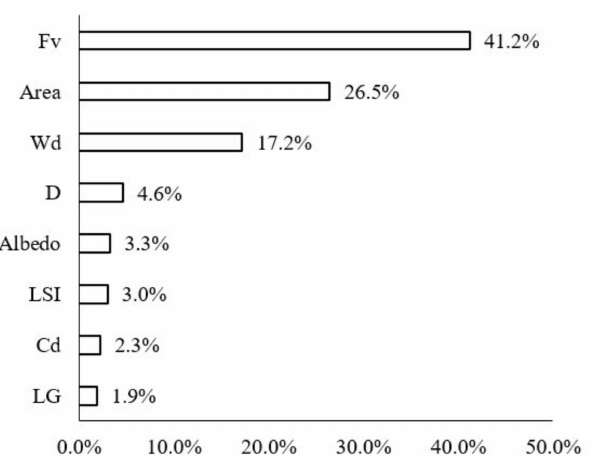
Figure 18. Contribution ratios of each factor to the LST of the waterfront green space of Width-IV river